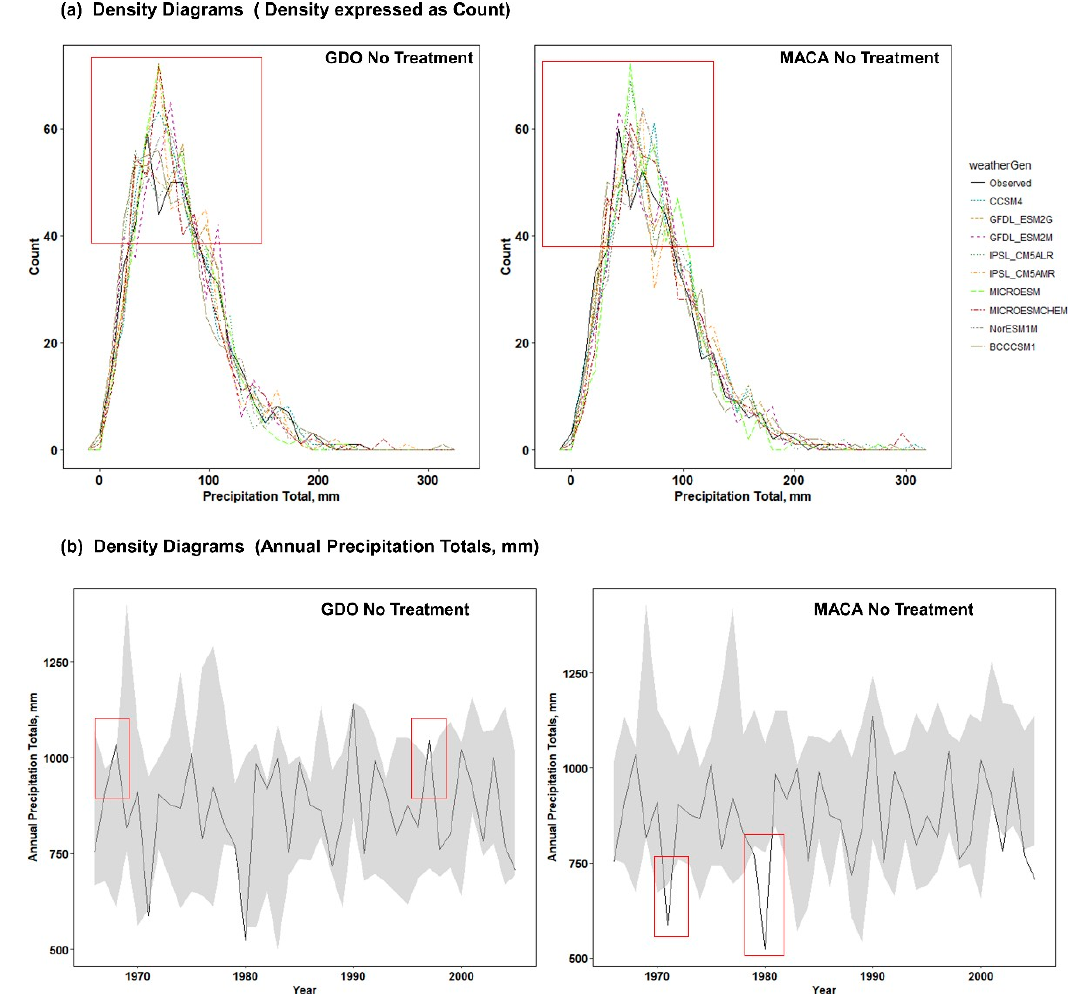
Figure 3. ( a ) Density distribution charts for Adrian, MI for monthly precipitation depths, mm; ( b ) Annual precipitation depths, mm, with range bounds from different GCM outputs. (Charts for Fort Wayne, IN and Norwalk, OH are presented in Figure S1A,B.)